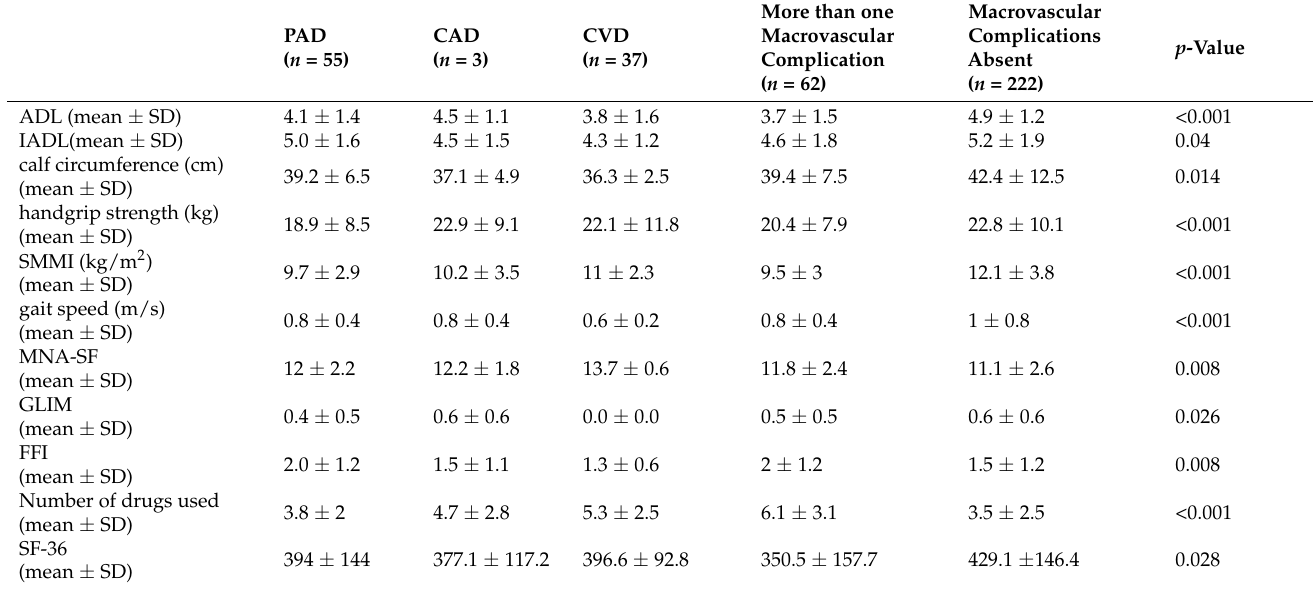
Table 4. Relationship between subgroups of macrovascular complications and geriatric syndromes.